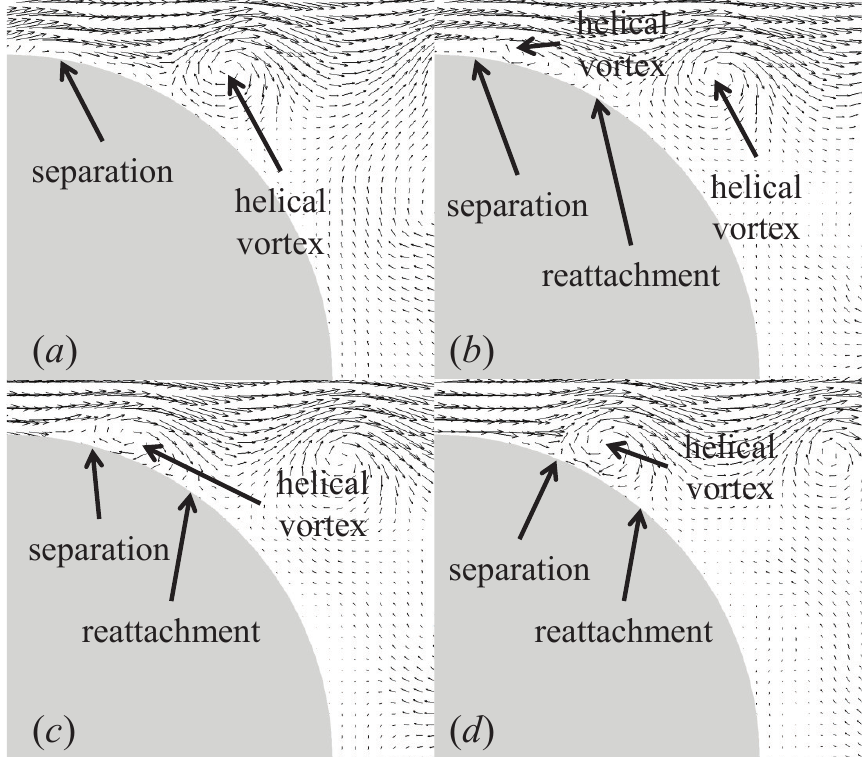
Figure 10. Instantaneous velocity vectors on the x – r plane ( θ = 0) in the near wake at different temporal instances owing to the periodically rotating distributed forcing ( f ∗ = 1.5 and V 0 / u ∞ = 0.2): ( a ) t = 0; ( b ) t = T /4; ( c ) t = 2 T /4; ( d ) t = 3 T /4. Here, T denotes the temporal period defined to be T = 1/ f . Note that the forcing slot locates from φ = 84 ◦ to φ = 96 ◦